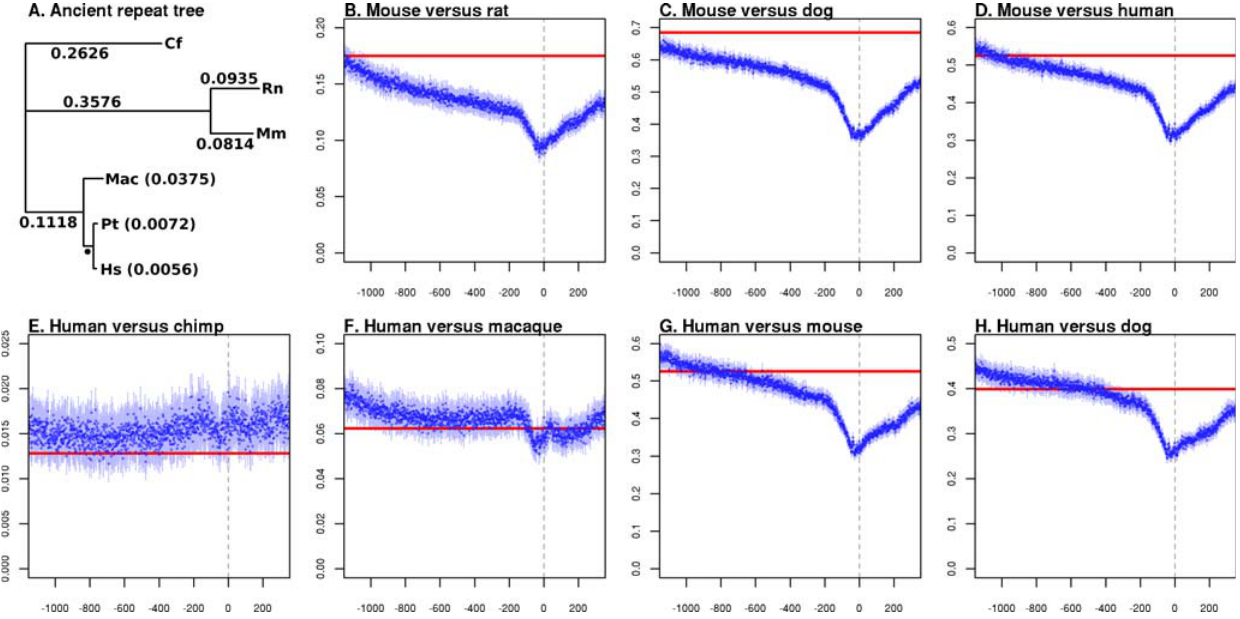
Figure 2. Relative Selective Constraint across Mammalian Promoters (A) Nucleotide substitution rates ( K, substitutions per aligned nucleotide) calculated from AR alignments. Rates for each branch are shown along the branch where possible, otherwise in parentheses after the species abbreviation. A single black spot indicates the branch length 0.0192, which could not be accommodated on the graph. (B–H) Pairwise substitution rate estimates (with 95% confidence intervals indicated) showing both the substitution rate ( K , y- axis) calculated from ARs (red) and at each nucleotide position across the promoter region (position shown on the x- axis). In every case, the 95% confidence interval for ARs is contained within the plotted line. The TSS position at þ 1 is indicated by a grey vertical line. (B–D) Mouse-based alignments of TSSs defined in mouse. (E–H) Human-based alignments of TSSs defined in human. Cf, Canis familiaris; Hs, Homo sapiens; Mac, Macaca mullata; Mm, Mus musculus; Pt, Pan troglodytes; Rn, Rattus norvegicus . DOI: